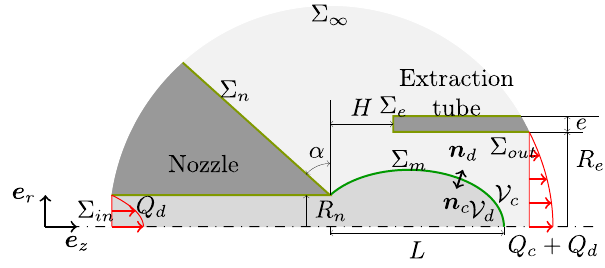
Figure 5. Sketch of the droplet generation inside a Raydrop.